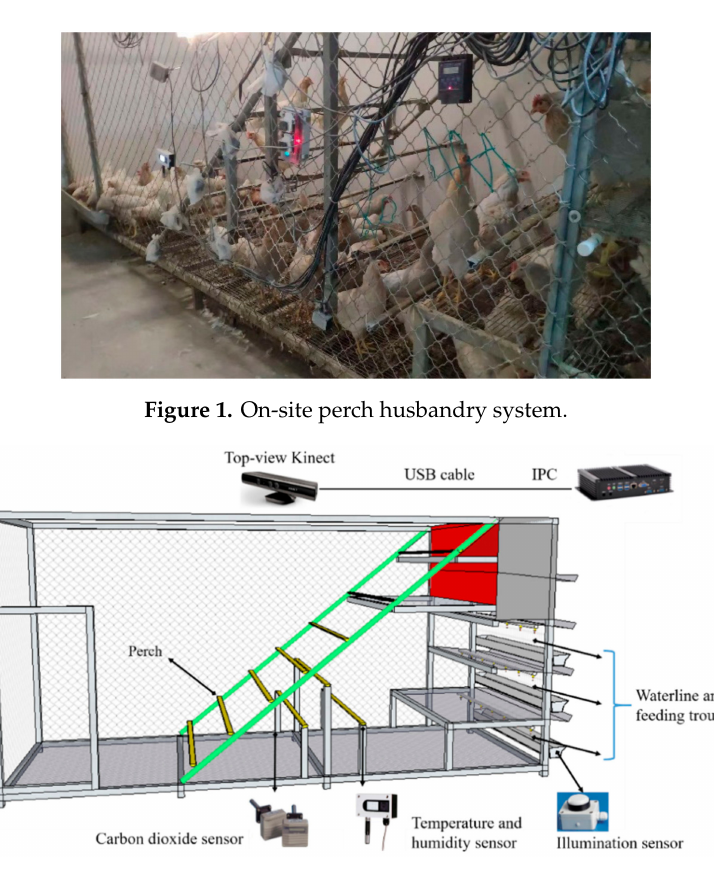
Figure 2. Schematic of the experiment platform. Table 1. Description of di ff erent hens’